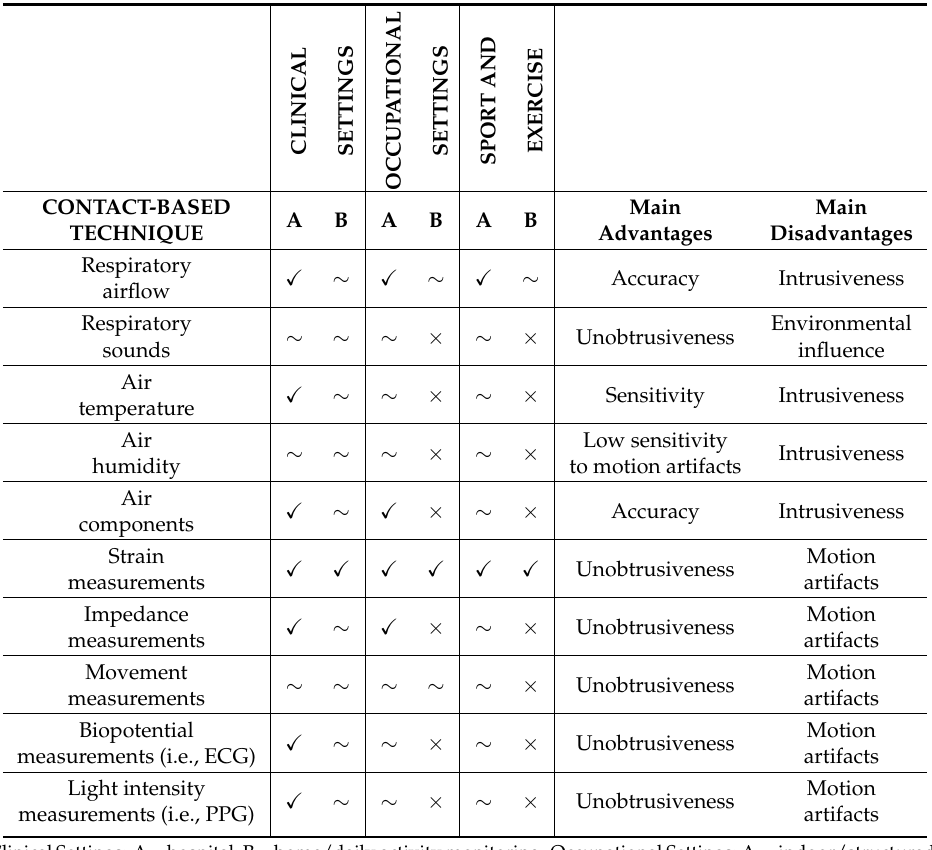
Table 10. Suitability of the different contact-based techniques for monitoring f R in three main fields of application (i.e., clinical settings, occupational settings, and sport and exercise). Each of the three fields has been divided into two parts: part A assesses the suitability in more controlled or structured environments; part B assesses the suitability in less structured or controlled environments. Main advantages and main disadvantages of the different contact-based techniques for monitoring f R are also reported. (cid:88) good to excellent, ∼ sufficient, ×